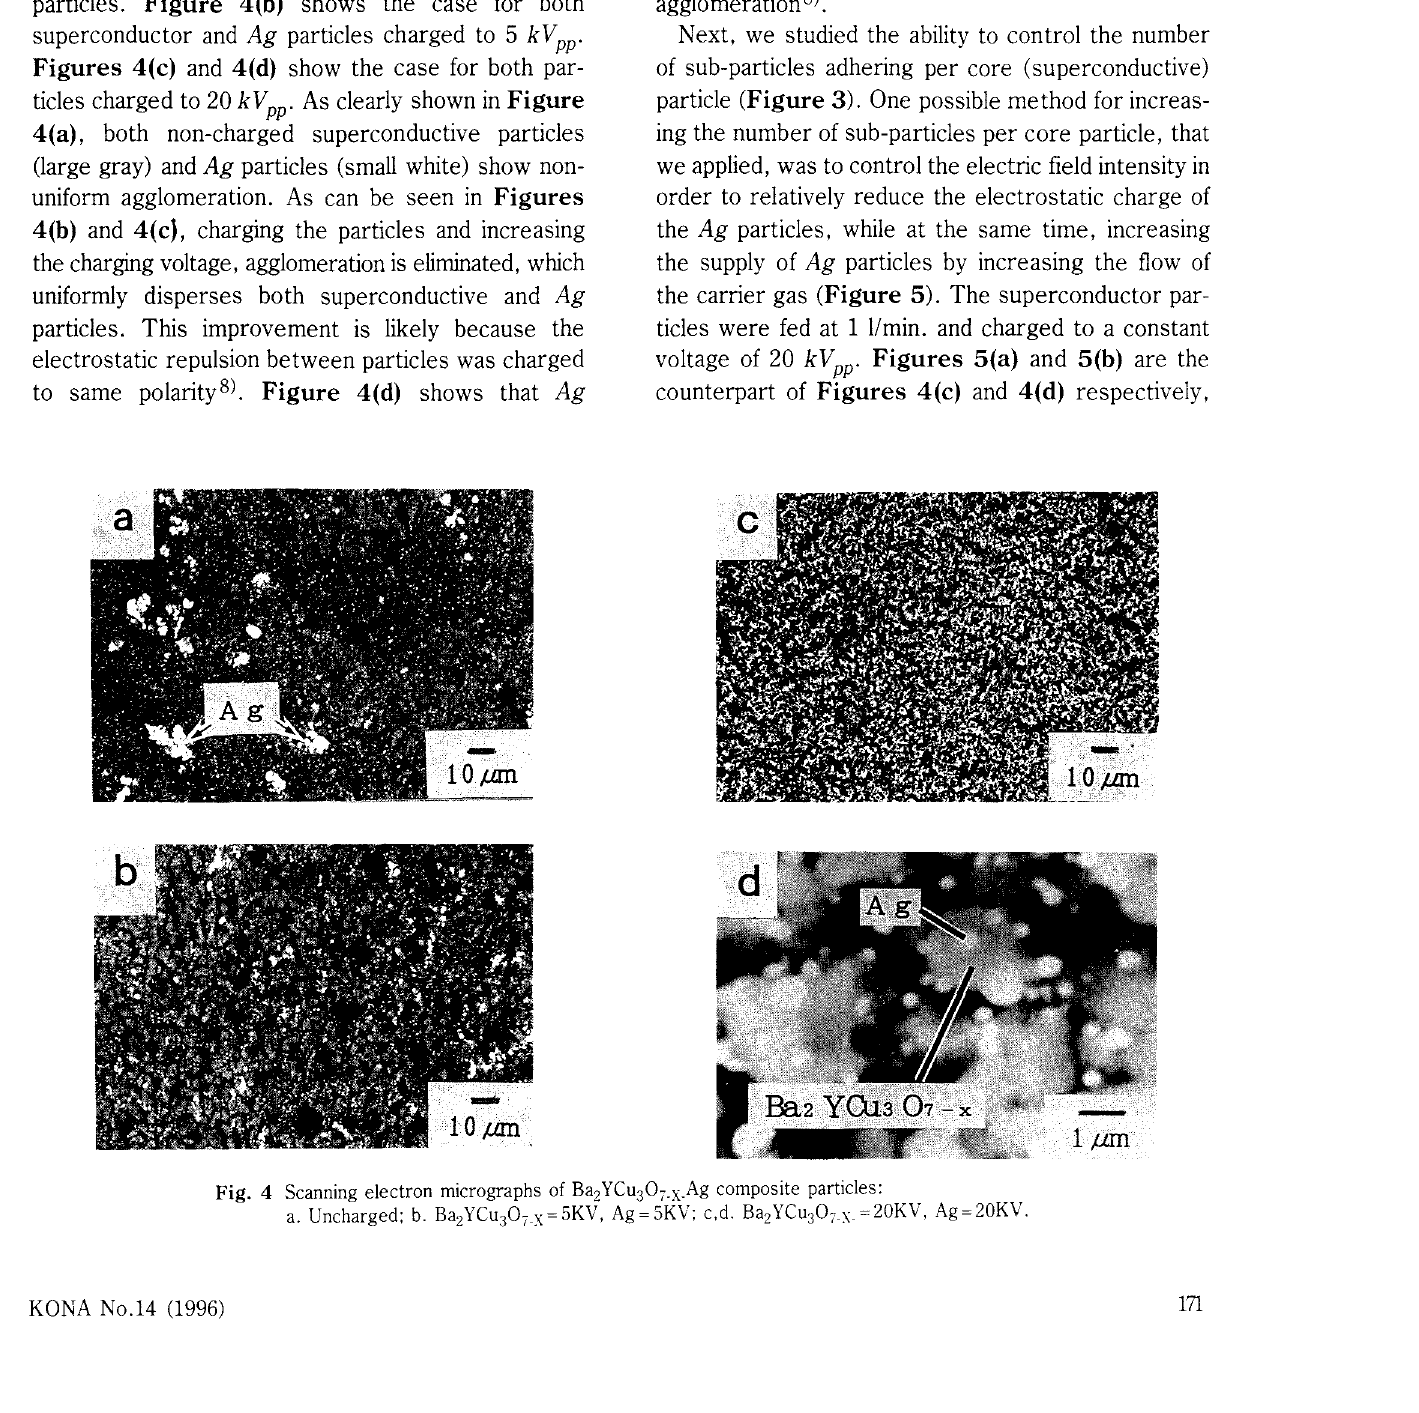
Fig. 4 Scanning electron micrographs of Ba 2 YCu 3 0 7 .x_Ag composite particles: 0 a. Uncharged; b. Ba YCu x=5KV, Ag=5KV; c,d. Ba 2 YCu 3 0 7 x =20KV, Ag=20KV. 2 7 3